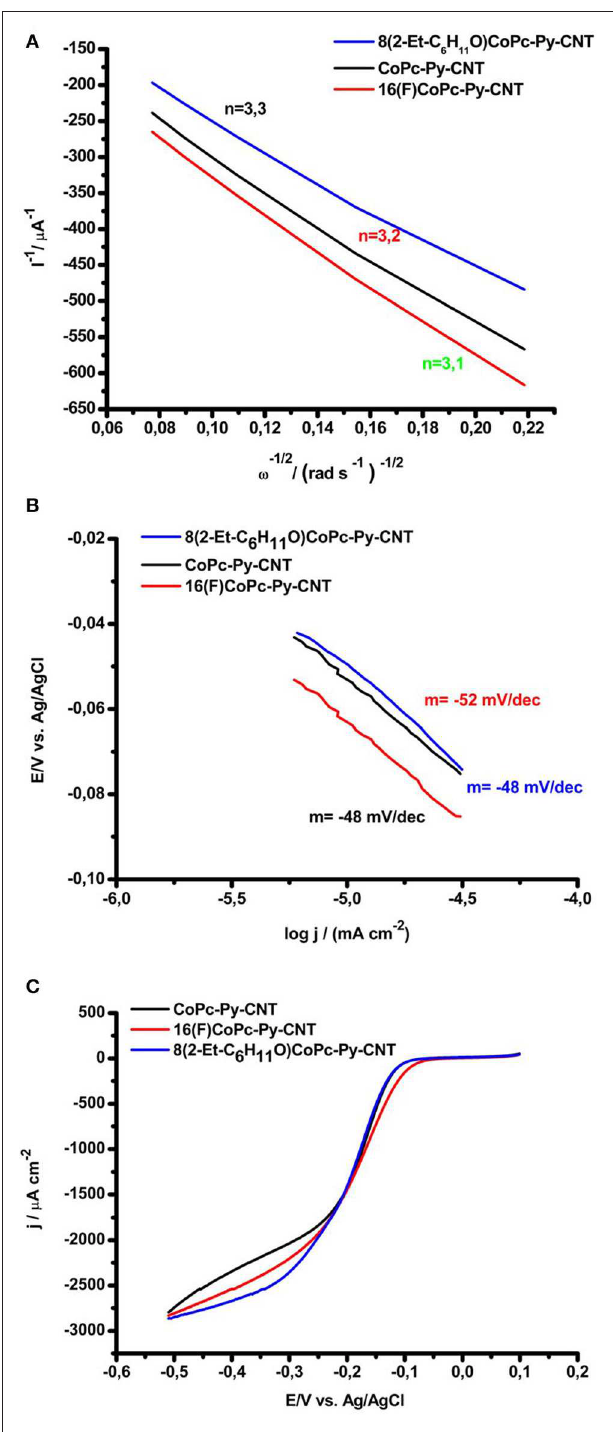
FIGURE 6 | (A) Koutecky–Levich plots for O 2 reduction for